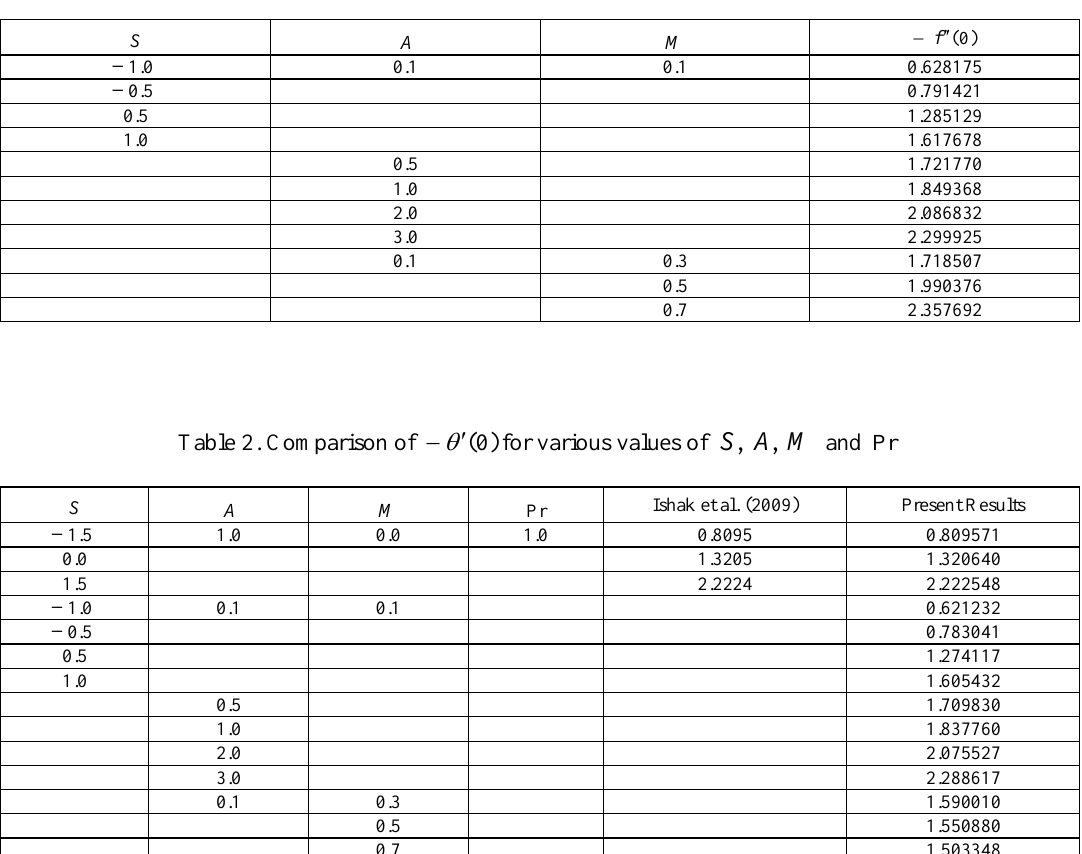
Table 1. Values of